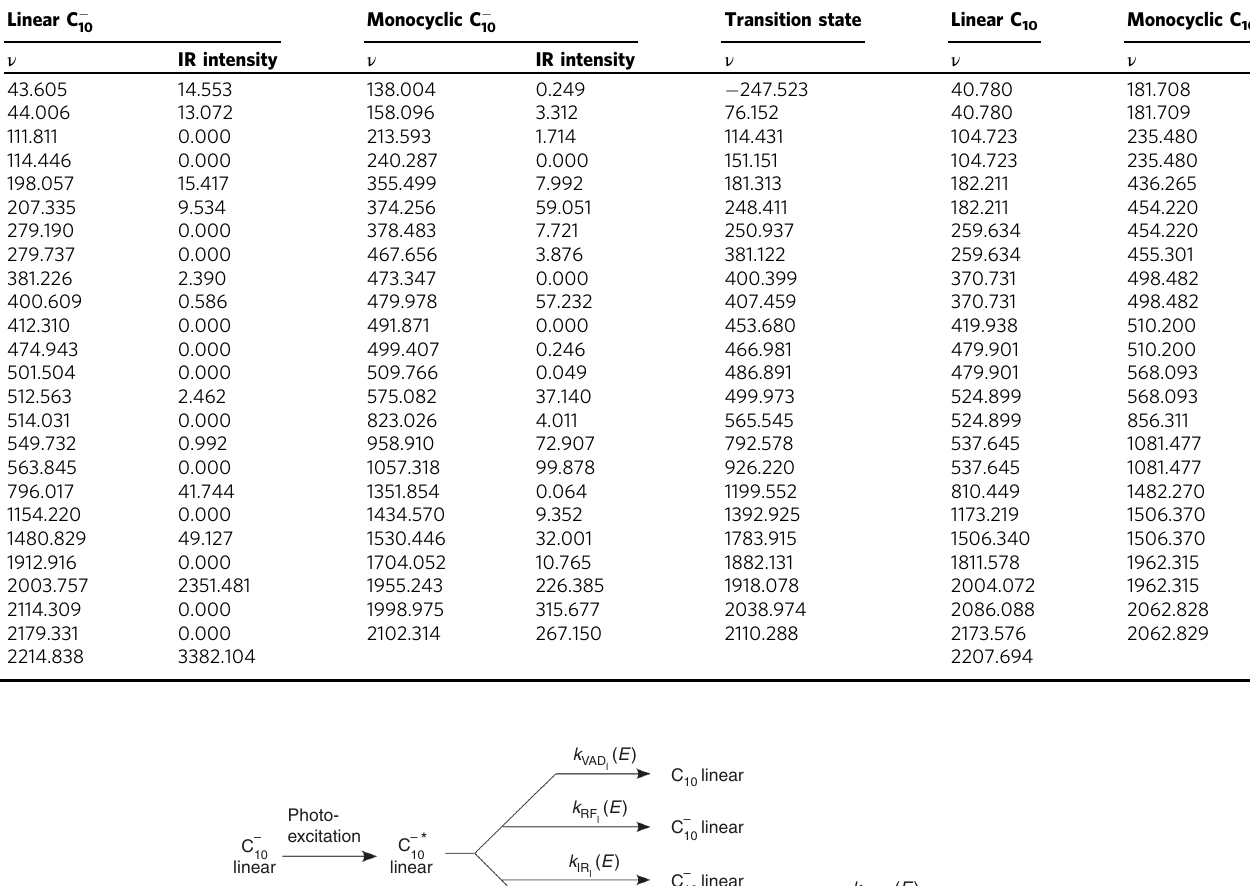
Table 1 Vibrational frequencies ( ν , cm − 1 ) and IR intensities (km mol − 1 ) of the linear and monocyclic C (cid:1) frequencies ( ν , cm − 1 ) of the transition state and linear and monocyclic C 10